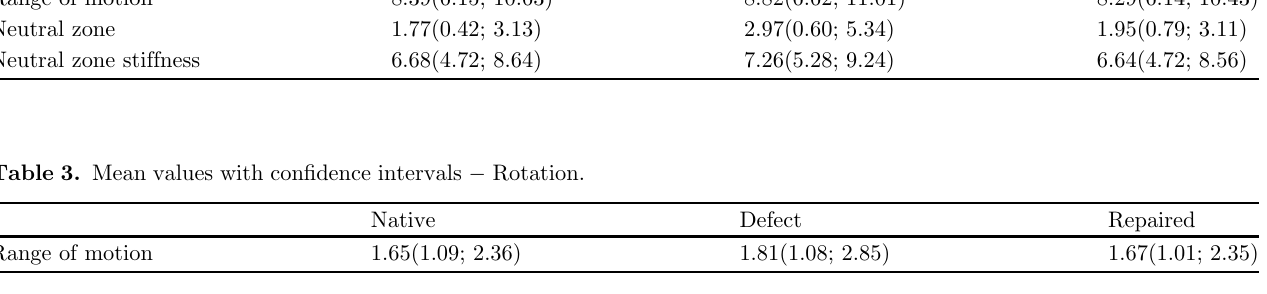
Table 2. Mean values with con fi dence intervals (cid:1) Lateral bending. Native Defect